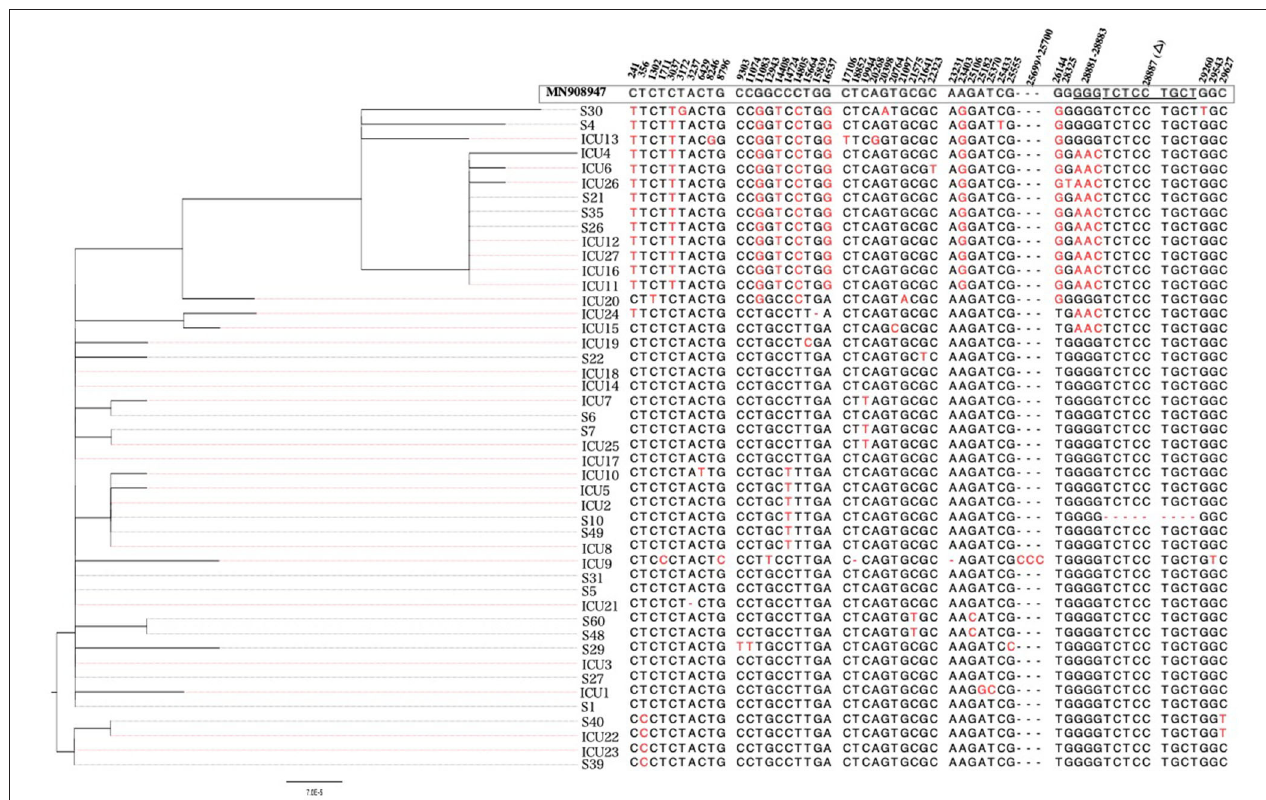
FIGURE 3 | Phylogenetic tree of sequenced SARS-CoV-2 viruses ( n = 46 samples). Maximum likelihood phylogeny was reconstructed under the general-time reversible model (GTR) as inferred by model testing. Nucleotide sequence alignment shows mutations found at the consensus level ( > 50% frequency) with respect to the reference strain